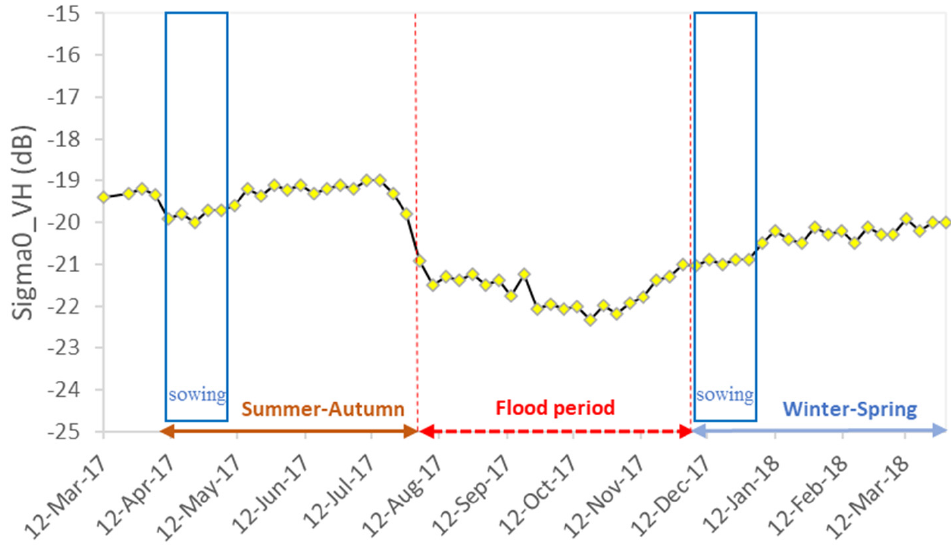
Figure 8. Dynamic Otsu thresholds on the Sentinel-1 SAR image time series.